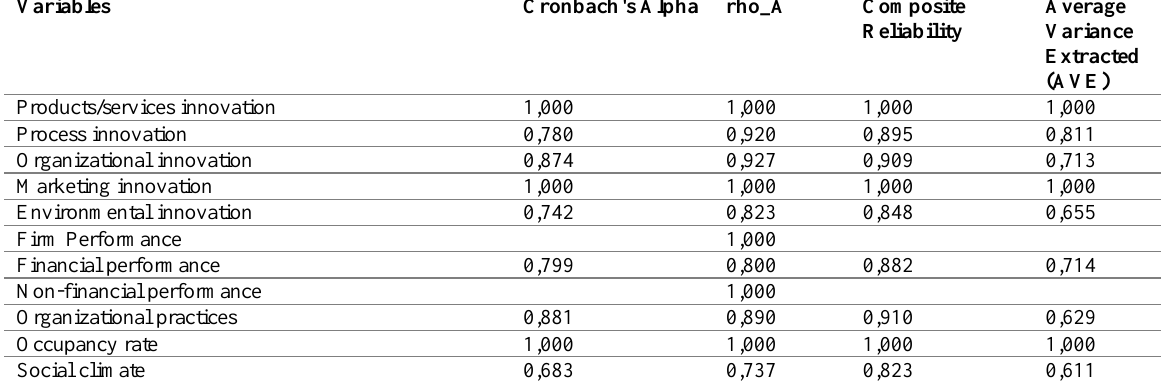
Table 6: Validity of the measurement